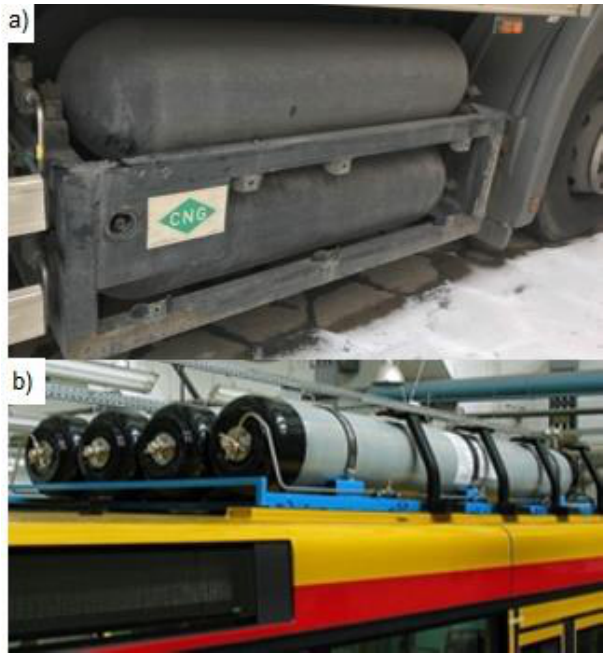
Fig. 9. Method of mounting CNG tanks: a) composite-aluminum ones on the frame of a truck; b) composite on the roof of a city bus [12]